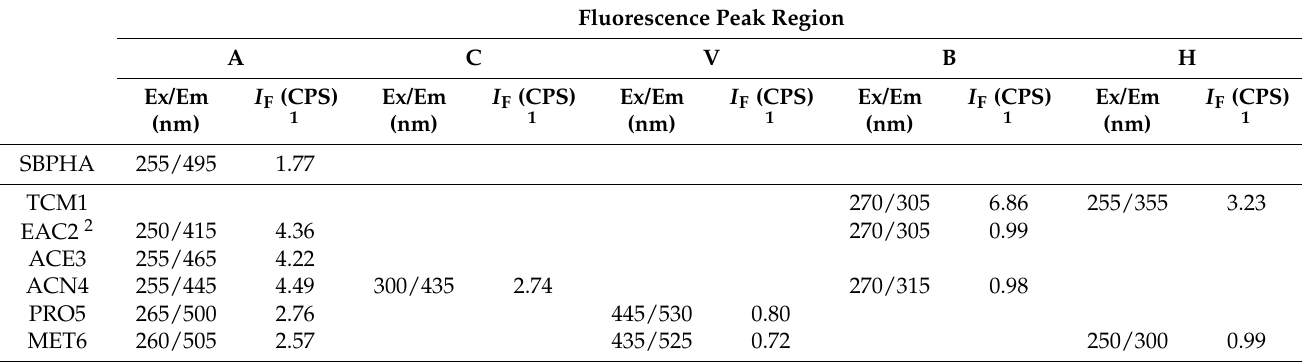
Table 3. Positions of excitation-emission wavelength pairs for fluorescence domains and values of fluorescence intensities for organic fractions and original peat